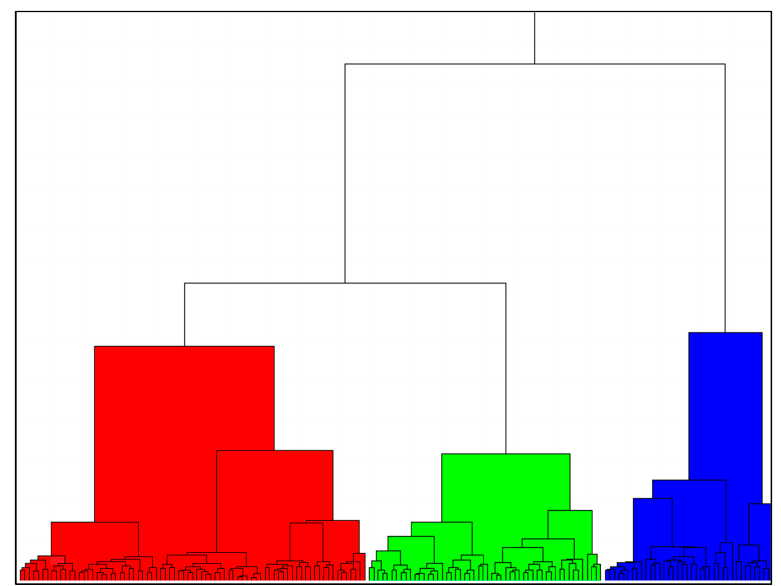
Figure 5. Cluster map: dendrographic classification of 168 dialectological points (324 morphosyntactic features).